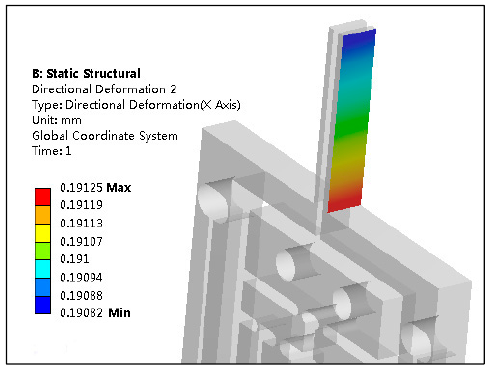
Figure 5. The displacement cloud diagram of the left gripping jaw.